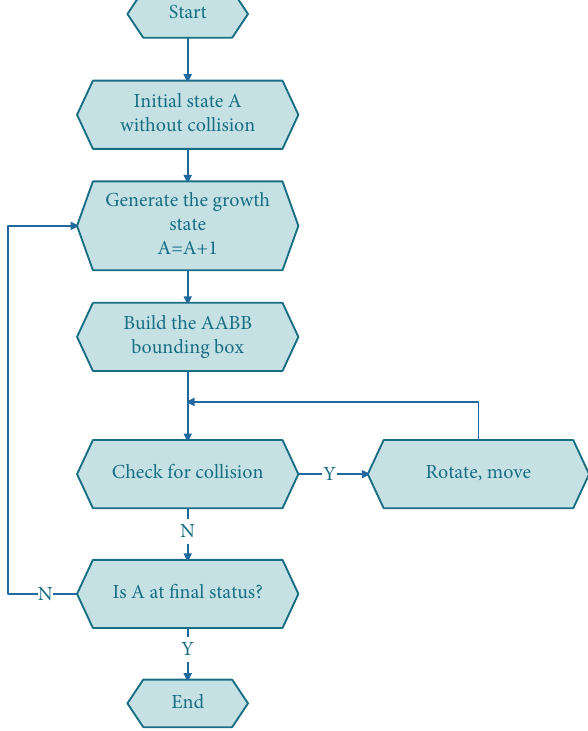
Figure 7: Collision detection process.